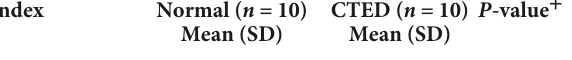
TABLE 7 Baseline characteristics of normal controls vs. those with chronic thromboembolic